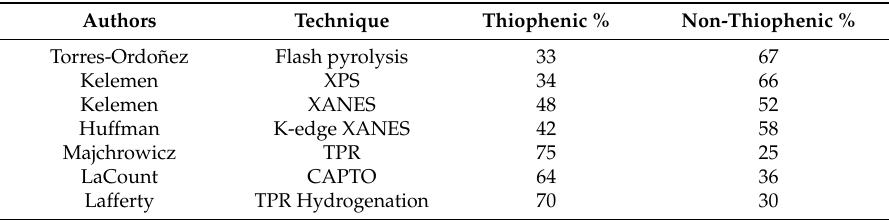
Table 1. Mequinenza lignite results for various